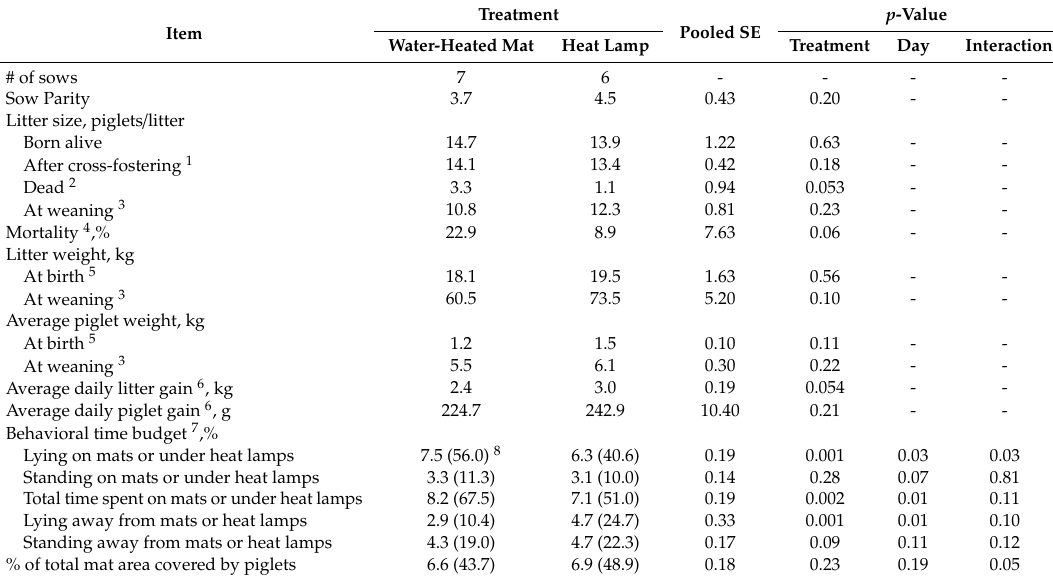
Table 1. Behavior and performance of piglets using water-heated mats or heat lamps (Trial 1). p -Value Treatment Pooled SE Item Water-Heated Mat Heat Lamp Treatment Day Interaction 7